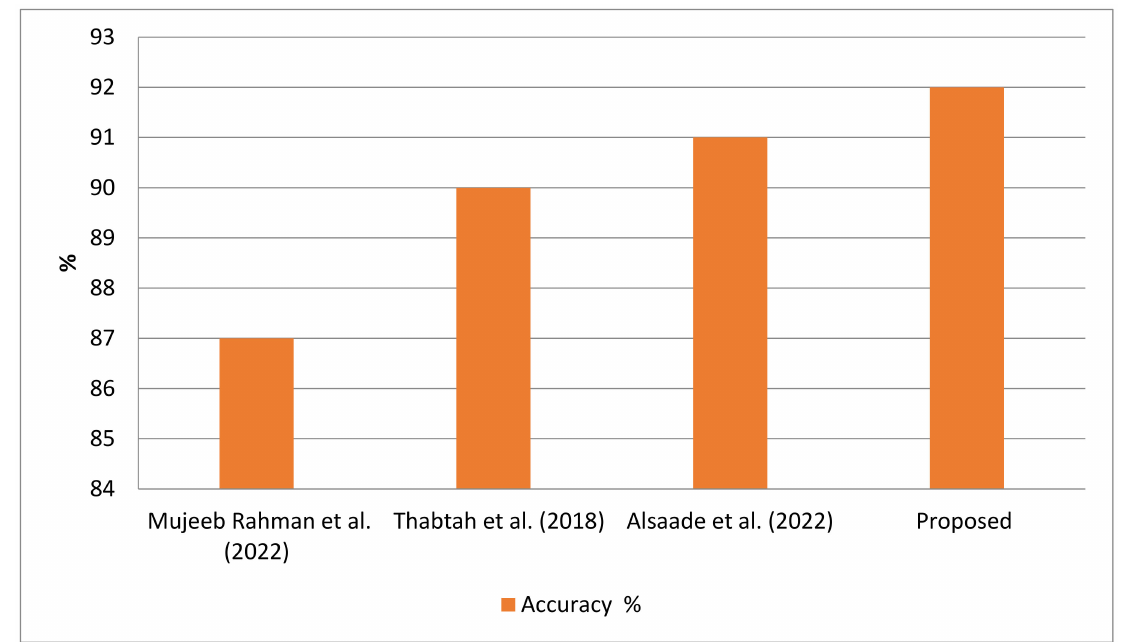
Figure 19. Comparison of the proposed and existing systems. Histograms represent references [10,24,46] (from left to